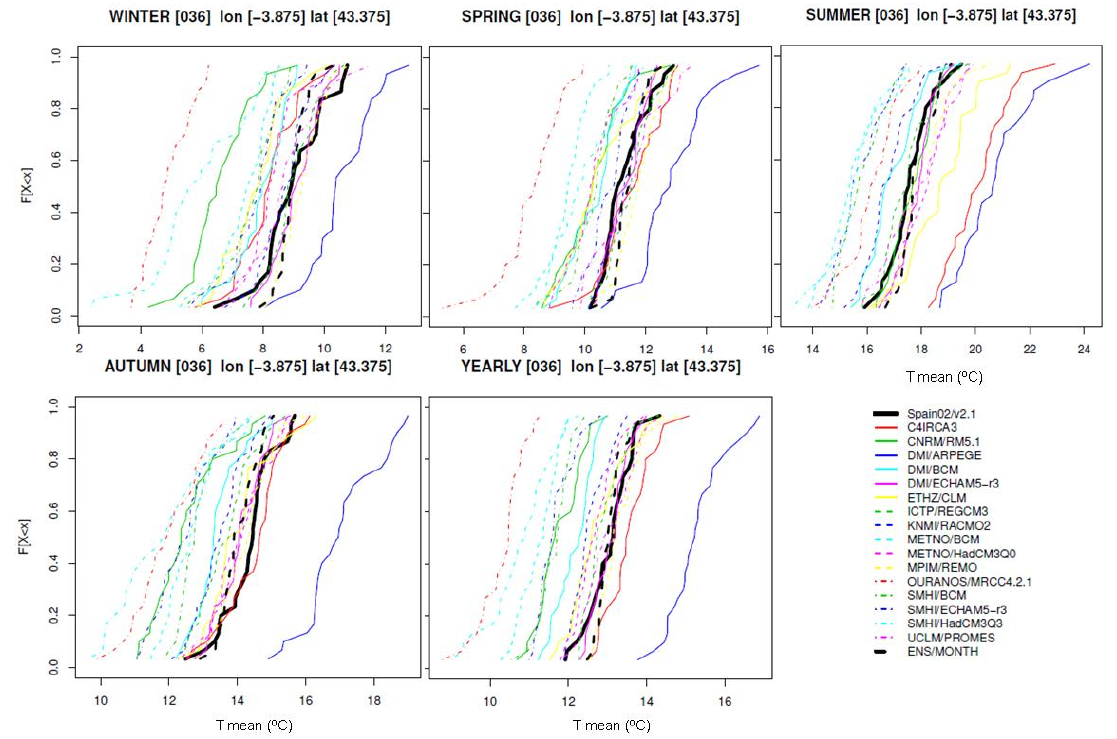
Figure 3. Cumulative density probabilities functions (CDFs) of mean temperature on site 36 from observed dataset (in black), ensembles (dashed black), and RCMs (in colour), for time reference period 1961–1990.